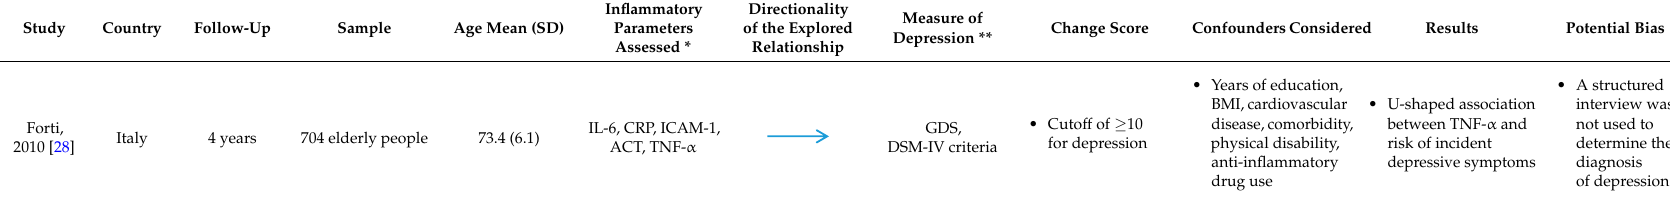
Table 1. Main characteristics of cohort studies included in the